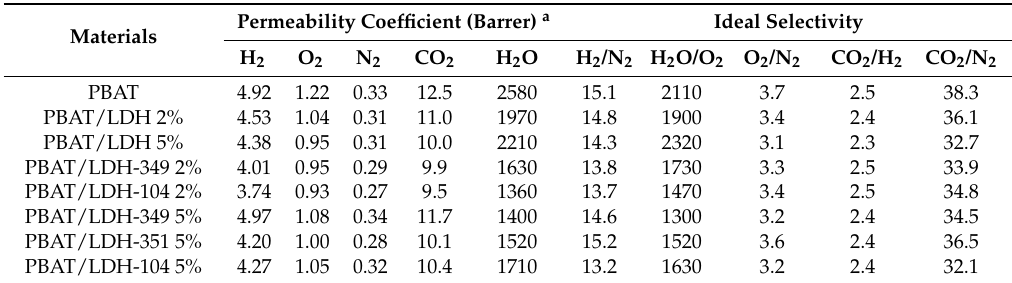
Table 2. Dependence of gas and water vapor permeability coefficients and corresponding ideal selectivities in PBAT polymer materials containing different amount of pristine and